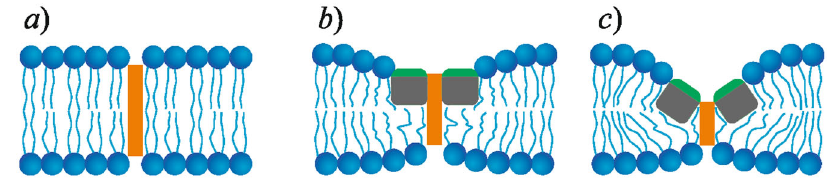
Fig.8|Threepossiblewaystoformahydrophobicdefect(orangerectangle).a purelylipidmembrane; b fl atFPcluster; c funnel-likestructureintheFPclusterformed by tilted FPs. The hydrophobic defect length decreases from a to c